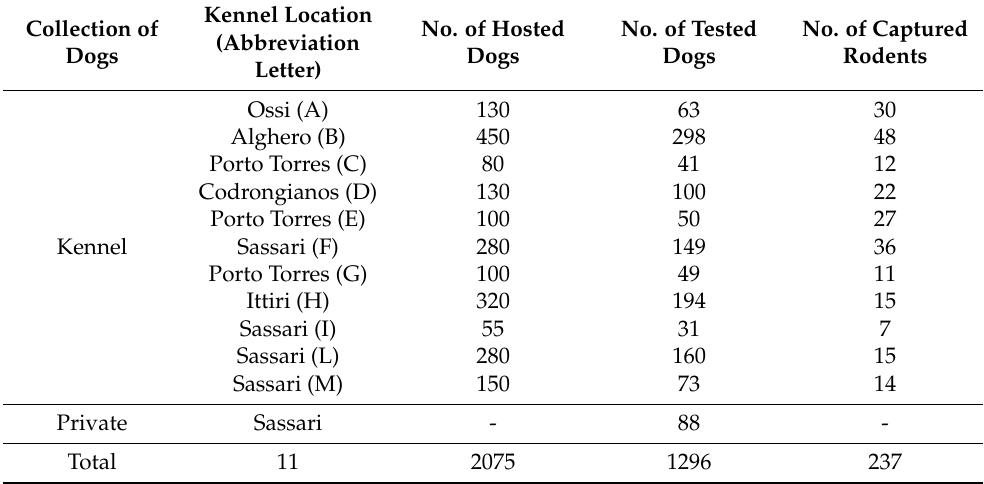
Figure 1. Geographical distribution of the 11 kennels analyzed in this study (red dot) and of the owned dogs (green dot). Table 1. Summary of dogs and rodents analyzed in this study, sites where kennels were located, and relative number of captured